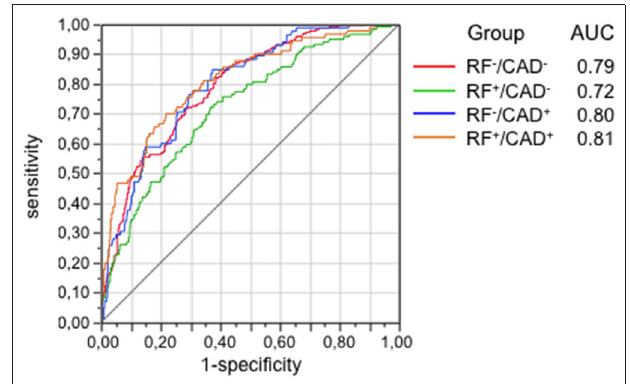
FIGURE 4 | Boxplots of atrial myosin regulatory light chain 2 (MYO) in subjects with a Leaman score of < 5 vs. ≥ 5 and of protein shisa-3 homolog (PS-3) by